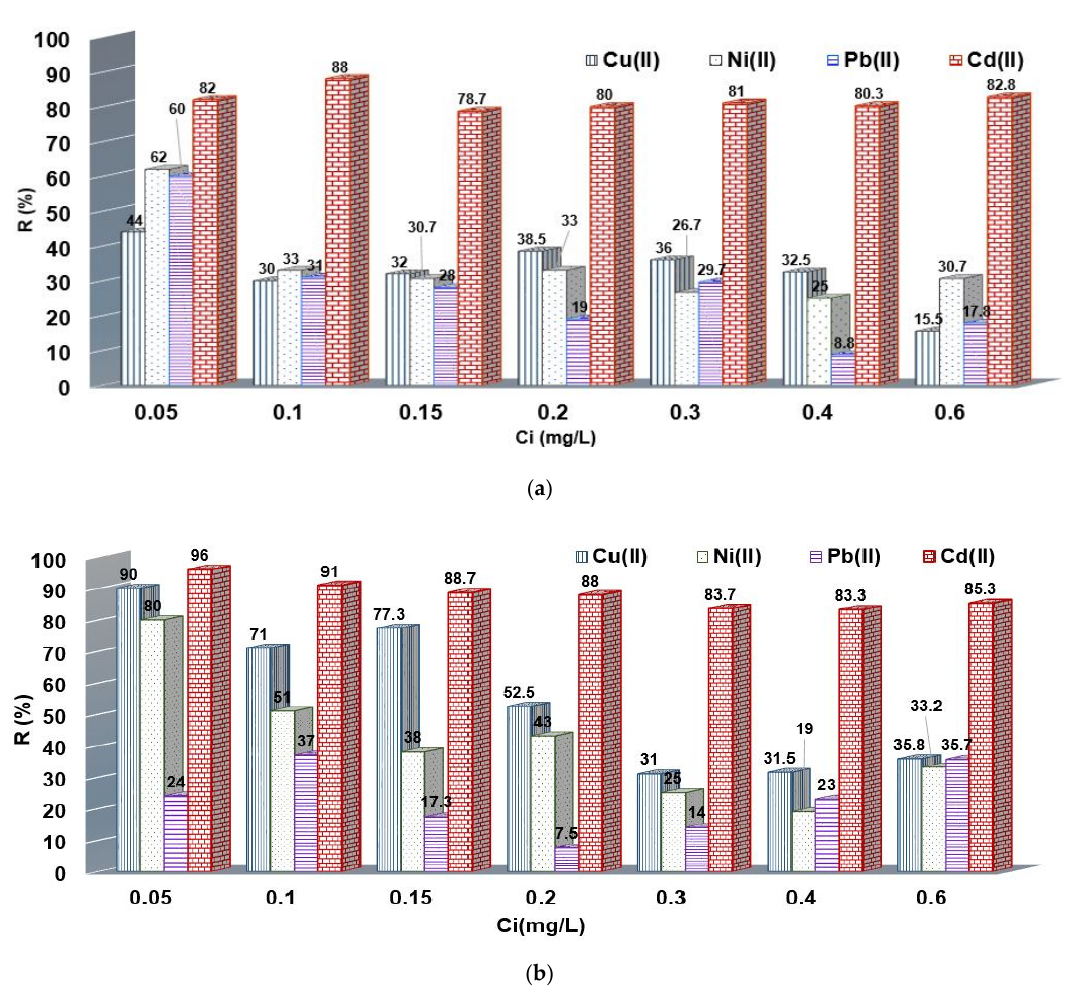
Figure 6. Cd 2+ , Cu 2+ , Ni 2+ and Pb 2+ removal on ( a ) IRA 402-DR 23 and ( b ) XAD7HP-DR 23. Table 2. Comparison of IRA 402-DR 23 and XAD7HP-DR 23 with other adsorbents used for the removal of hazardous metal